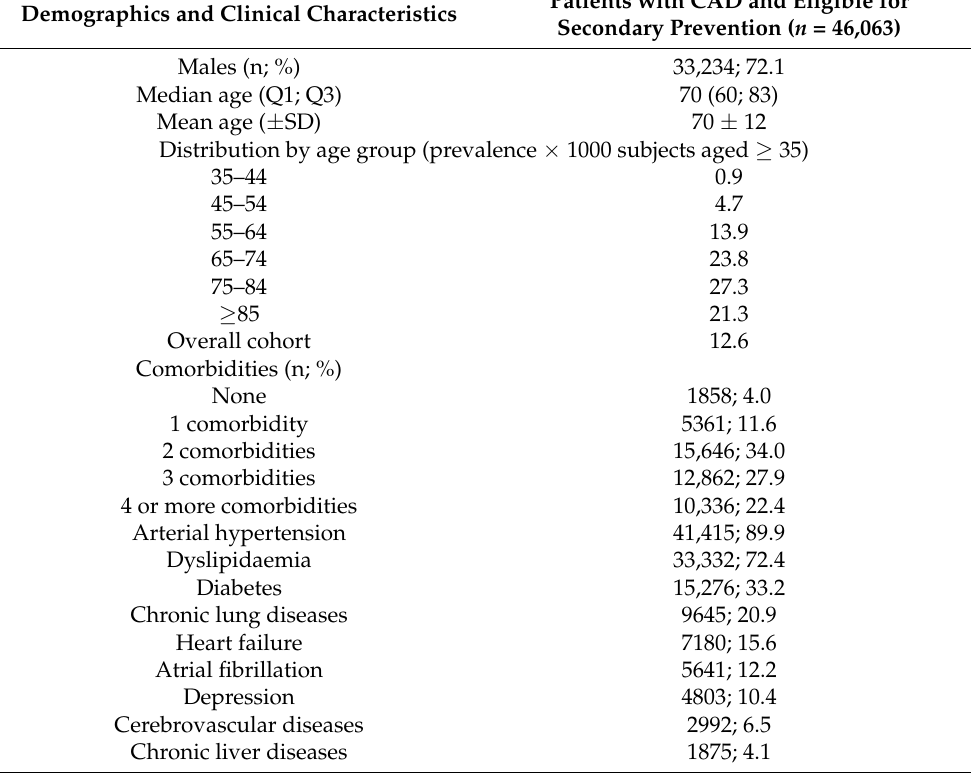
Table 1. Characterization of the cohort of patients affected by CAD and eligible for long-term secondary prevention treatments in 2018 among ReS population aged ≥ 35, in terms of demographics at the index date and of comorbidities in the available previous period.